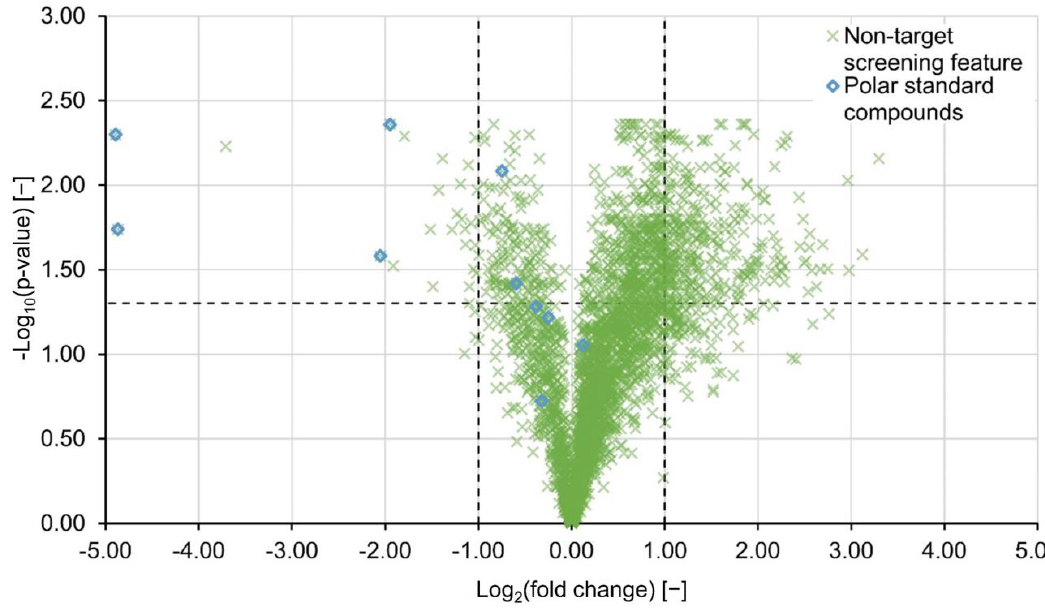
Figure 3. Scores plot of the PCA based on the normalized peak heights of the feature extracted from each individual measurement.